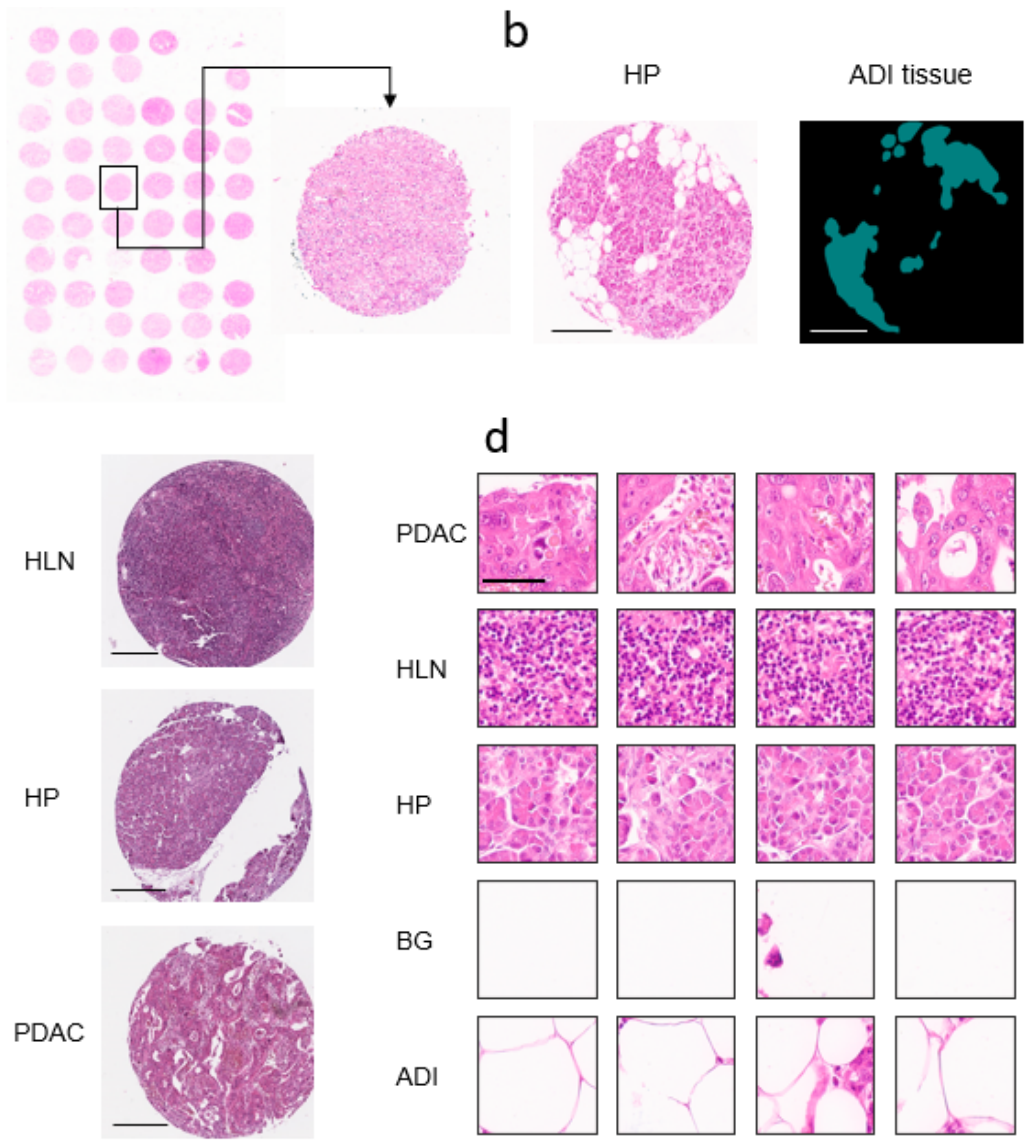
Figure 1. Data Pre-processing Pipeline for H&E-stained Tissue Micro Arrays provide datasets for Deep Transfer Learning. ( a ) Patients’ data were extracted from tissue micro arrays (TMAs) and annotated. ( b ) A representative HP Spot with adipose tissue and a segmentation of the adipose tissue are shown (scale bar = 300 µ m). ( c ) Spots from healthy lymph node (HLN), healthy pancreas (HP) and pancreatic ductal adenocarcinoma (PDAC) (scale bar = 300 µ m). ( d ) Whole images were cut into square patches with 224 × 224 pixel sizes (scale bar = 60 µ m). PDAC, HLN, HP, Background (BG), and Adipose Tissue (ADI) sample image tiles are shown.